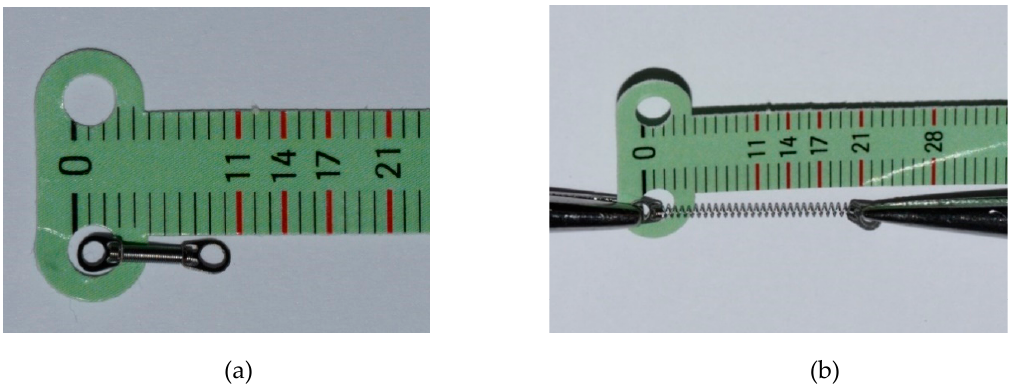
Figure 2. ( a ) The closed NiTi coil spring of 9 mm used for the study; ( b ) The NiTi coil spring activated with a force of 50/N.